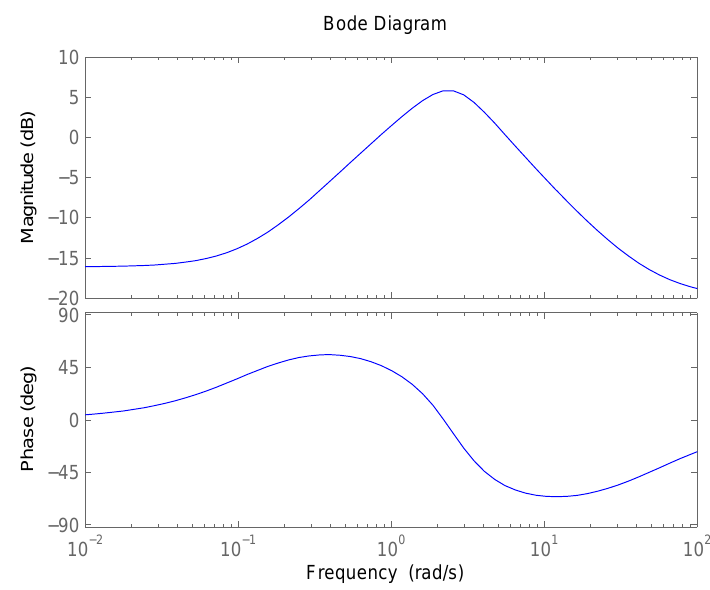
Figure 4. Bode diagram of the radiation damping term (5) normalized to 1 MNm/(rad/s).